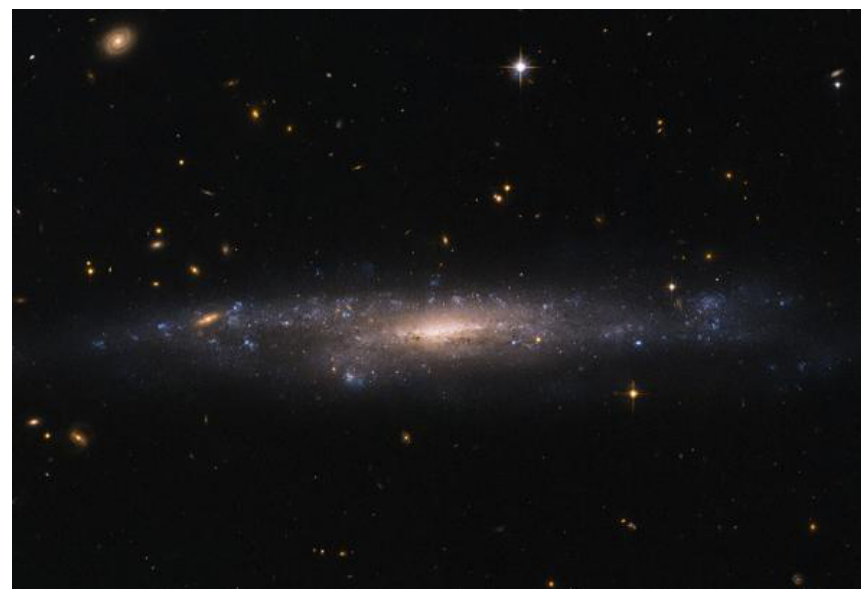
Figure 1. A typical LSB galaxy (UGC 477). Credits: ESA/Hubble and